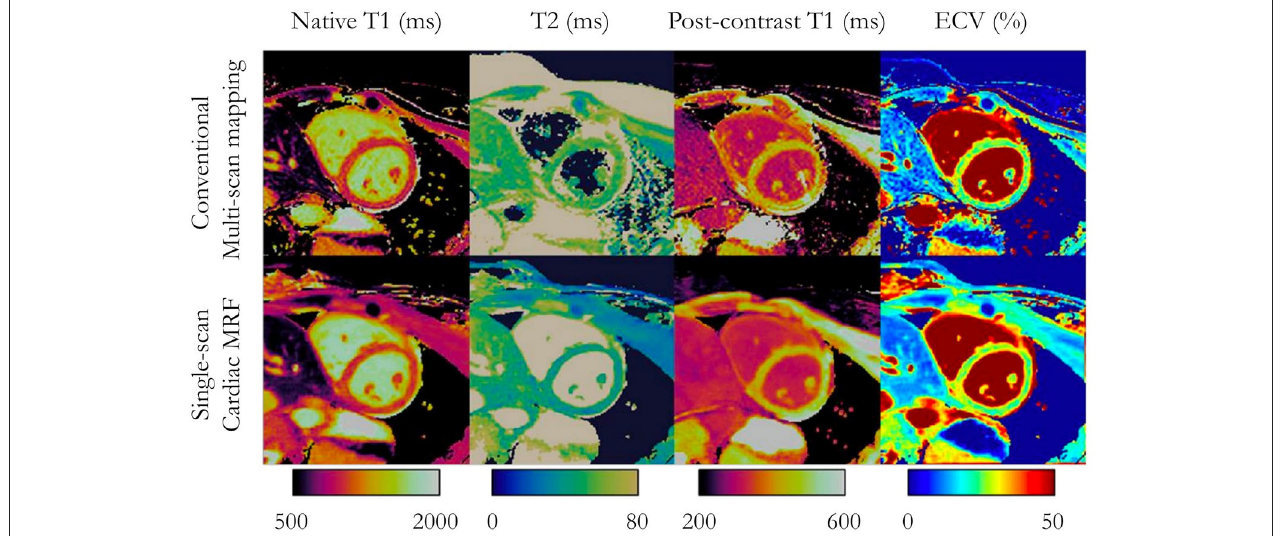
FIGURE 7 | Multi-parameter mapping. Comparisons between conventional multi-scan native T 1 , T 2 , post-contrast T 1 , and synthetic ECV maps (top) with single-scan magnetic resonance fingerprinting (bottom) in a patient with no cardiac disease finding. Adapted with permission from Jaubert et al. (106). MRF, magnetic resonance fingerprinting; ECV, extracellular volume